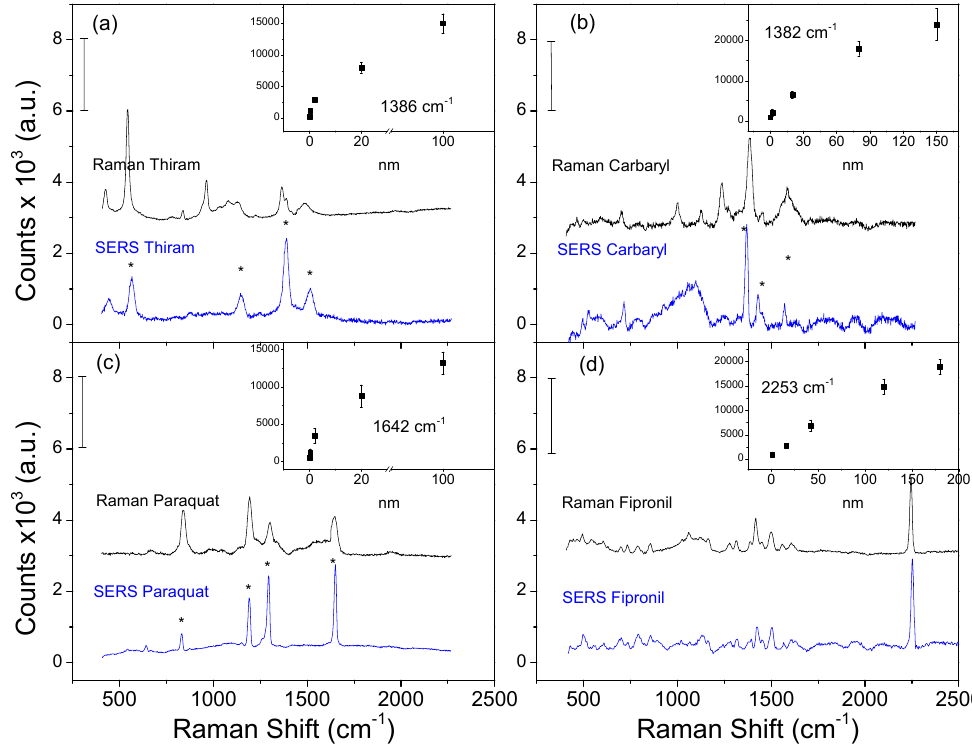
Molecules 2021 , 26 , x FOR PEER REVIEW Figure 6. The application of a 3D-RCW chip for direct and rapid detection of pesticides ( a ) thiram, ( b ) carbaryl, ( c ) paraquat, and ( d ) fipronil with rational detecting ranges (nanomole), as plotted in the inserts. * improve the discriminant accuracy.